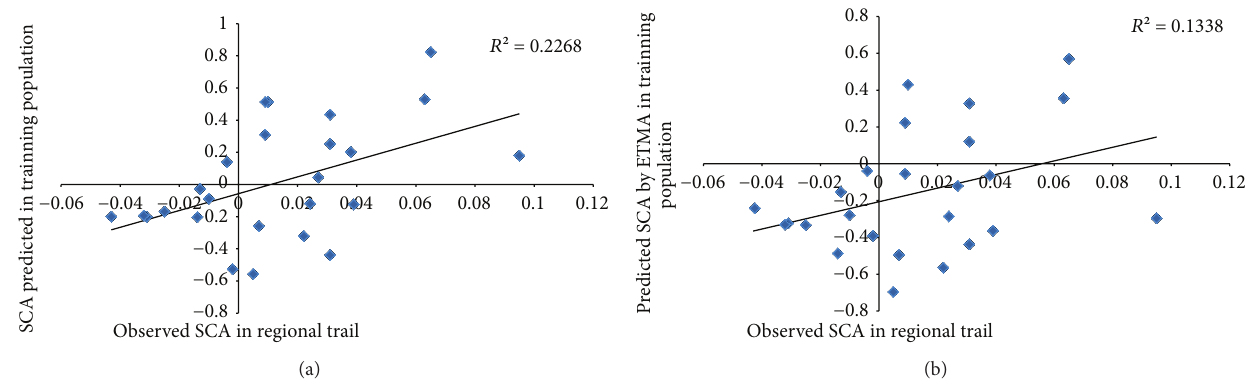
the traditional method and the total effects of associated markers